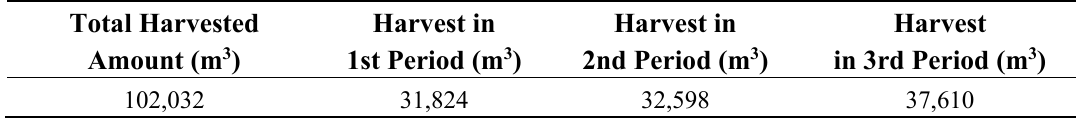
Table 1. The scheduled total amount of harvest and individual harvests for three planning periods for CP (cutting